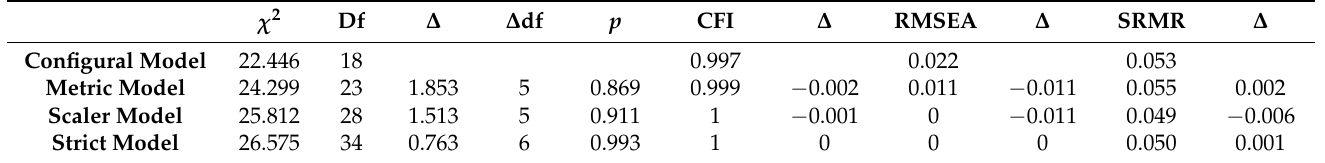
Table 4. Measurement invariance of the Problematic QQ Use Scale between boys and